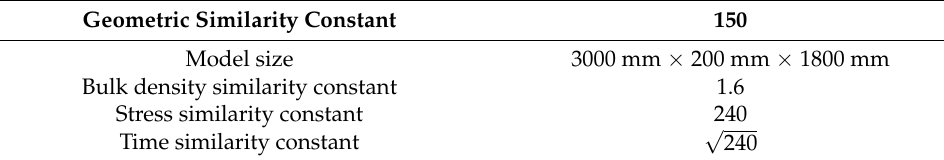
Table 2. Model similarity constants.